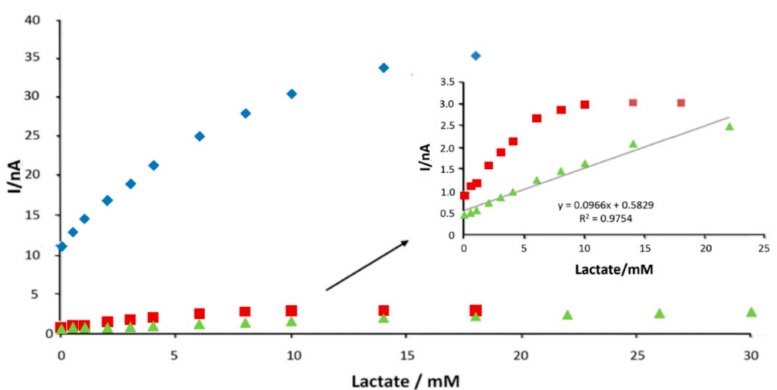
Figure 5. Lactate sensors with various inner and outer membrane combinations: 2% SPEES PES, 20% polyurethane (blue diamonds); 2% SPEES PES, 40% polyurethane (red squares); 10% SPEES PES, 40% polyurethane (green triangles). Lactate measured in pH 7.4 phosphate buffer, also containing 40 mg/mL BSA and 10 mM ascorbate. Enzyme layer used 25 U/L lactate oxidase from Pediococcus sp. No baseline correction.